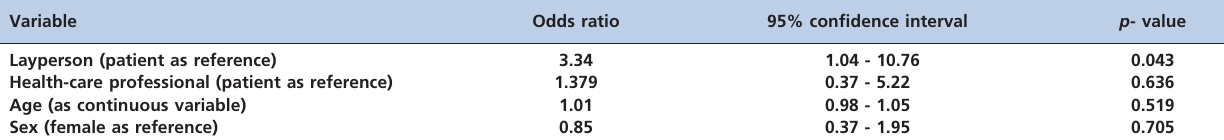
Table 3 - Multivariate analysis of factors predicting the choice to maximize quality of life in response to the second question on the questionnaire